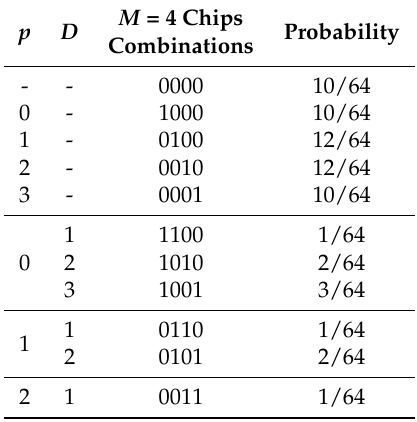
Table 2. Probabilites of M = 4 asynchronous chips.